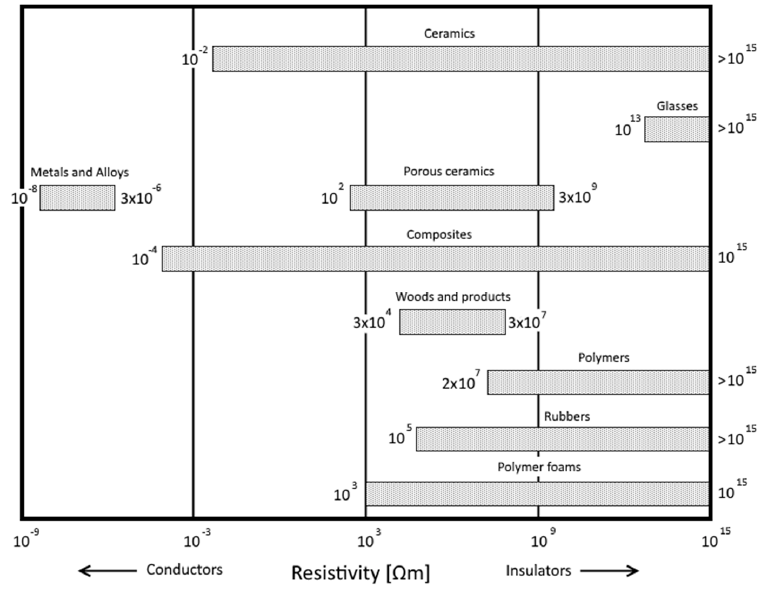
Figure 1. Electrical resistivity chart of various material classes.